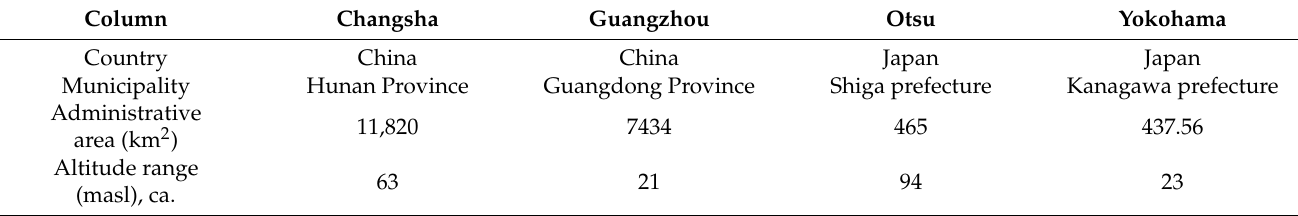
Table 1. Basic information on study